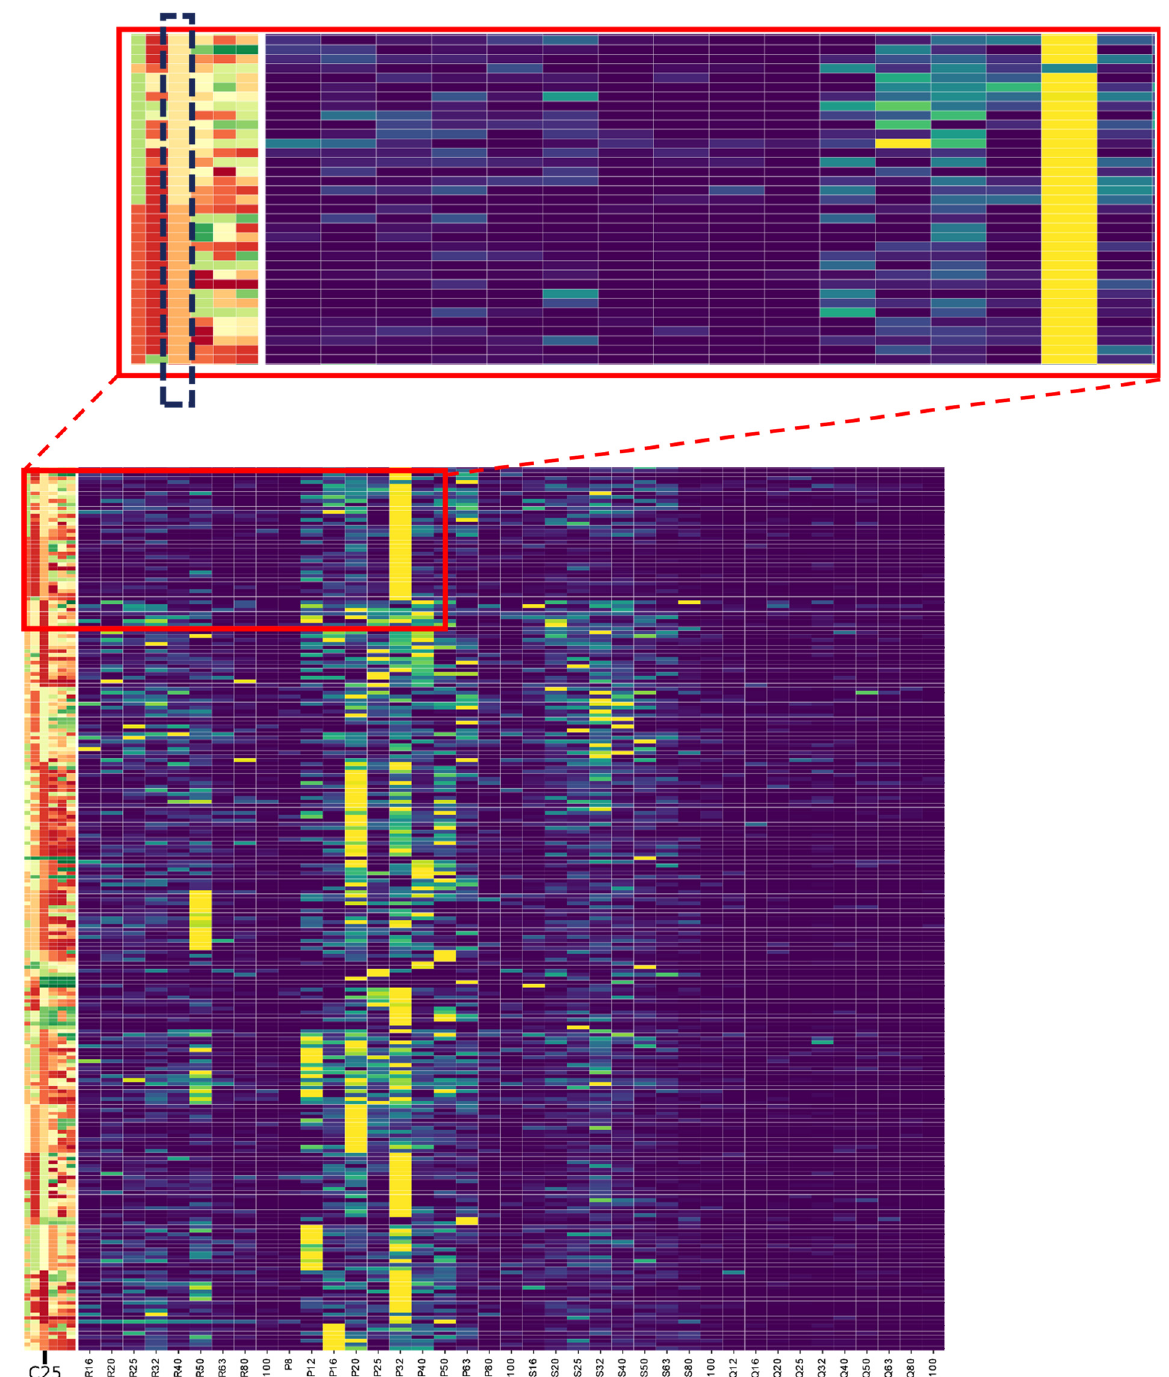
Figure 12. Heatmap of daily demand clusters.